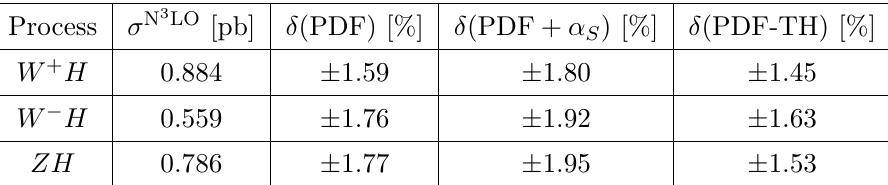
= M . The PDF set PDF4LHC15_nnlo_mc has been 0 HV , and PDF-TH uncertainties (in percent) are also given. S